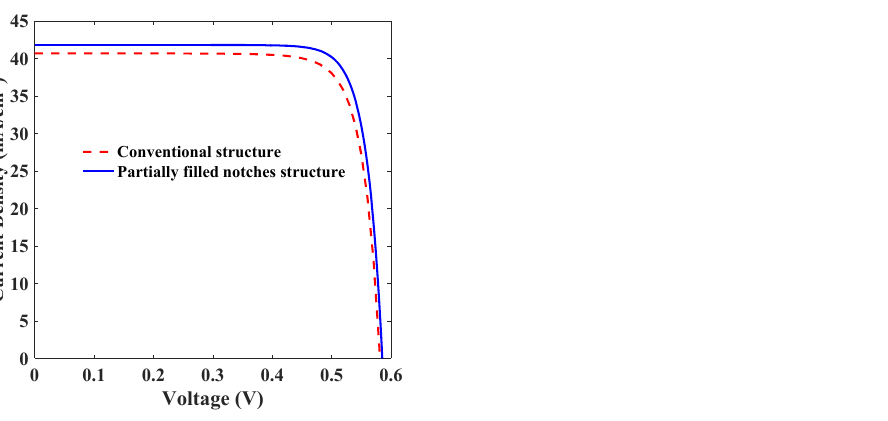
Figure 3. A comparison of illuminated J–V curves between the conventional and partially filled notches structures. Table 1. PV parameters of the conventional and the partially filled notches microstructures.